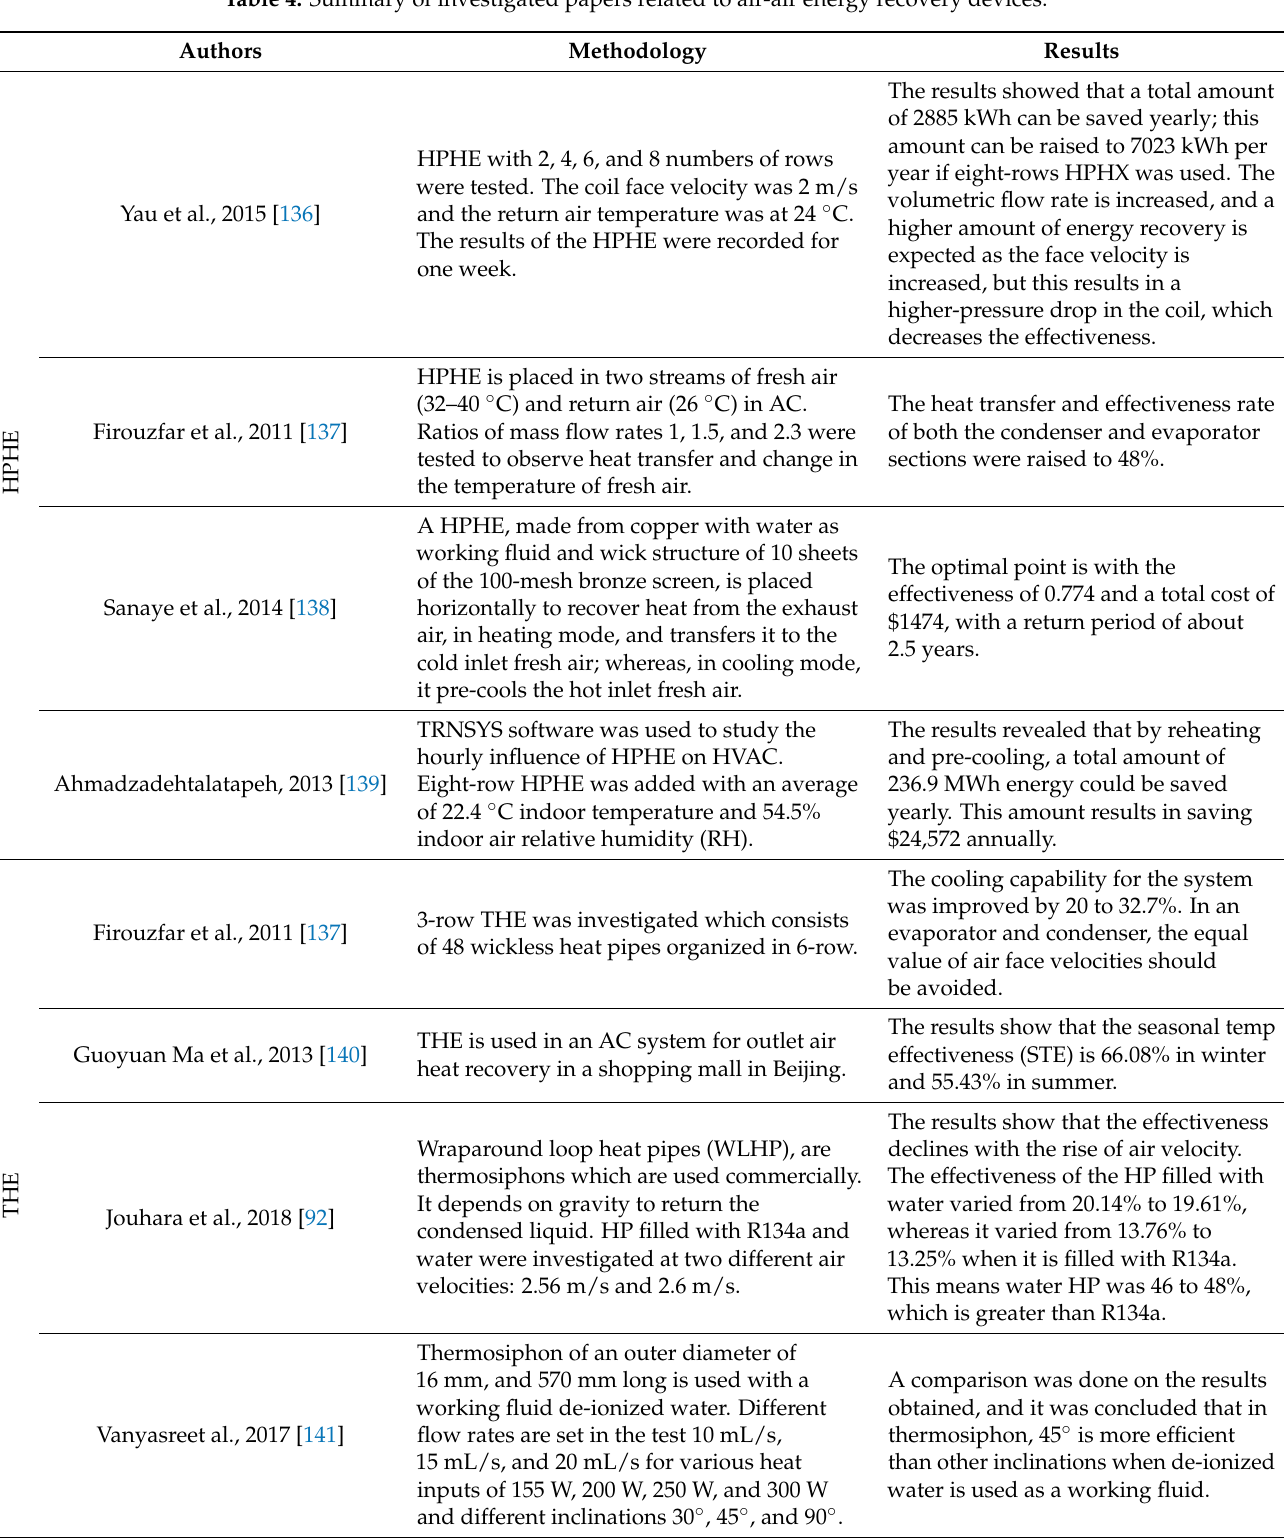
Table 4. Summary of investigated papers related to air-air energy recovery